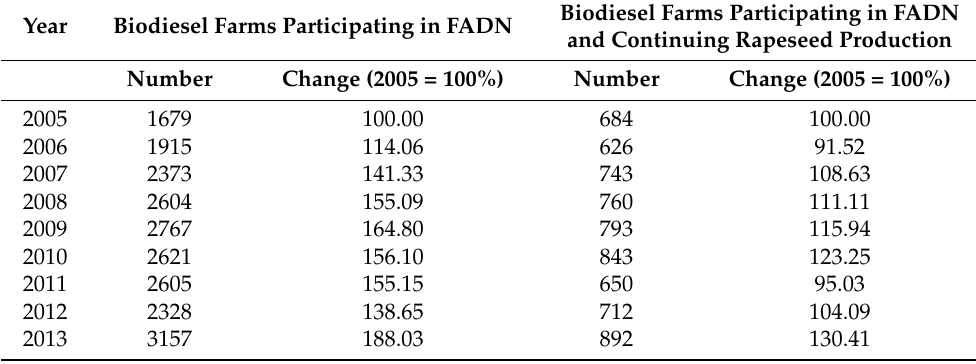
Table 1. Number of Polish biodiesel farms participating in FADN from 2005 to